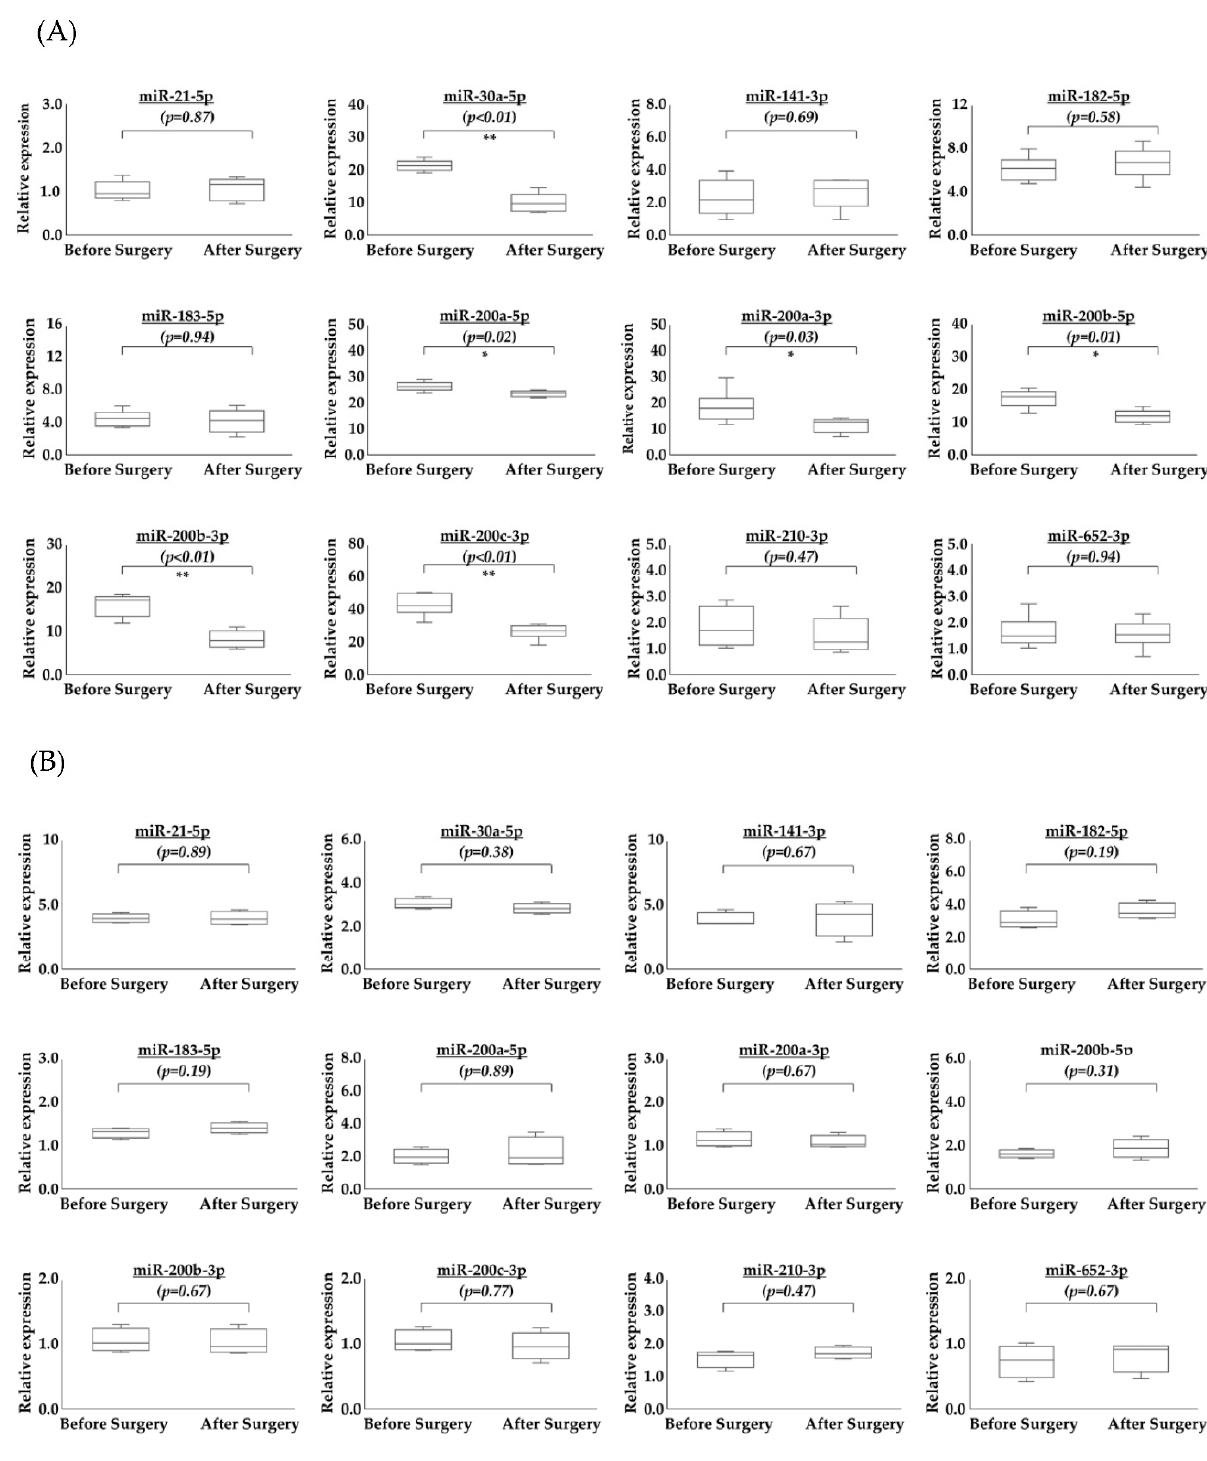
Figure 4. miRNA levels in serum extracellular vesicles (EVs) of patients with ovarian clear cell carcinoma. One serum sample was obtained before, and one after, surgery. ( A ) Six miRNAs (miR − 30a − 5p, miR − 200a − 5p, miR − 200a − 3p, miR − 200b − 5p, miR − 200b − 3p, miR − 200c − 3p) were significantly (** p < 0.01, * p = 0.0202, * p = 0.0306, * p = 0.0131, ** p < 0.01, ** p < 0.01 respectively) downregulated after surgery. ( B ) No significant differences were observed between samples obtained before and after surgery in patients with atypical endometrial hyperplasia patient (controls).